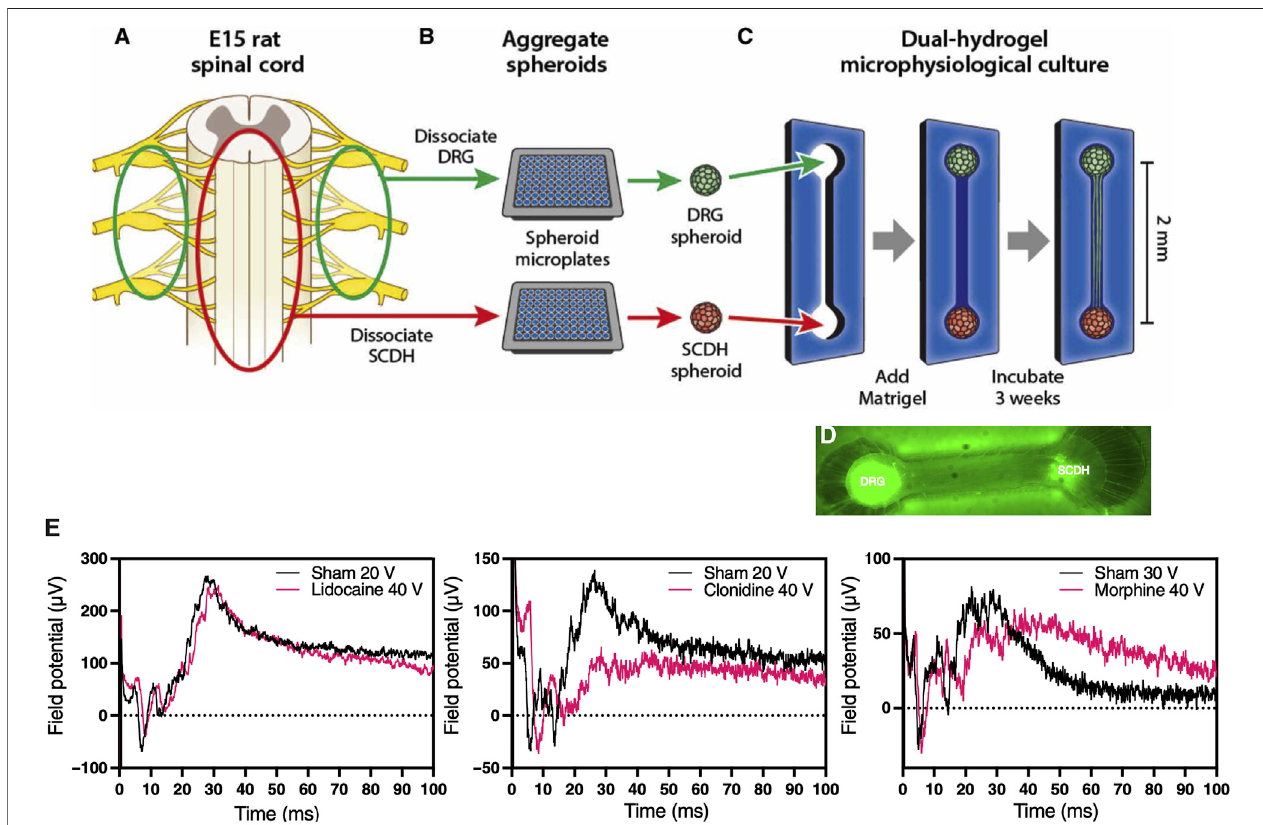
FIGURE 8 | Morphine-sensitive synaptic transmission in a microphysiological model of afferent nociceptive signaling. (A) Dorsal root ganglion (DRG) (green) and spinal cord dorsal horn (SCDH) (red) nerve tissues are harvested from E15 rat embryos. (B) Tissue is pooled by type, dissociated into a single-cell suspension, and aggregated in spheroid microplates to generate a batch of spheroids identical in size and composition. (C) A growth-restrictive outer-gel polyethylene glycol mold is fabricated to shape the cultures; spheroids are seeded in the mold, and the mold is fi lled with growth-permissive Matrigel. Over 3 weeks of culture, microphysiological tissue emerges (D) from which system-levelfunctionaldata areobtained. (E) Differentialdesensitization ofthe afferent DRG inputthroughtreatments with lidocaine (left), clonidine (middle), and morphine (right) traces. [Reproduced from (Pollard et al., 2021) with permission].